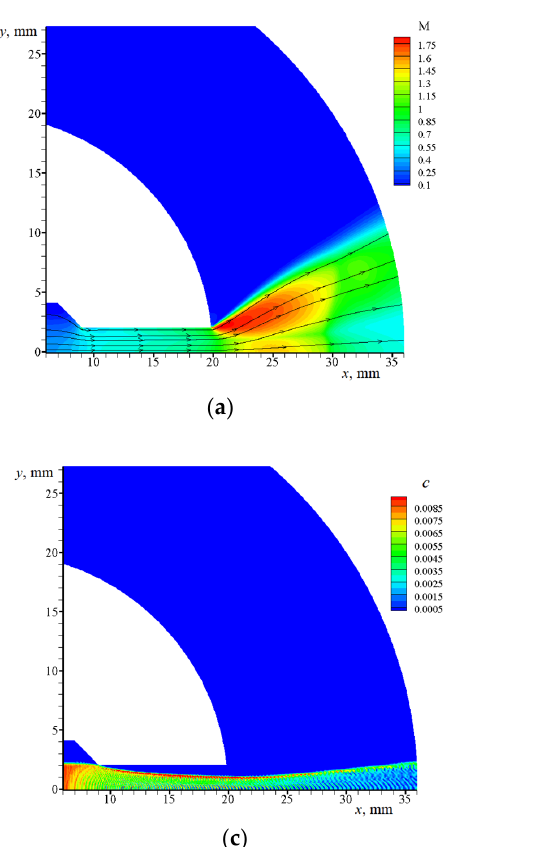
( b ) Figure 7. Results of experiments and calculations performed at 0.2 mm h  : ( a ) distributions of static pressure on the surface of the outer disk on the axis 0 y  in the experiment (symbols) and in the calculations (solid line); ( b ) soot ‐ oil coating on the surface of the outer disk in the presence of two channels of width 17 mm b  and 4 mm b  . The solid line in Figure 7a shows the calculated distribution of pressure along the jet axis. The dashed line shows the curve calculated without taking into account the friction force due to the disks, 0, 0 x y    . Evidently, within the experimental error, a satis ‐ factory agreement between the calculated and experimental results is observed. Figure 7b shows the soot ‐ oil coating shoot after the experiment on the outer disk without pressure holes yet with two channels. The boundaries of the channel and the jets exhausting into the flooded slot space correspond to the black lines in Figure 7b. This case corresponds to a fan ‐ shaped right jet, whose opening angle at the upper boundary of the jet is 25  , and at the lower boundary − 30  . A certain scatter in the angles of the jet opening is apparently due to the non ‐ parallelism of the disks. The calculated jet shown in Figure 5a is also fan ‐ shaped with a half ‐ angle of 30  . Both in calculations and experiments, a supersonic un ‐ derexpanded jet exhausting into a flooded slot space has a fad ‐ like shape. This was due to the action of the friction force on the jet from the side of the discs. In the absence of disks, the supersonic underexpanded jet exhausting into the flooded space has a barrel shape. Note that the numerical calculations described above were performed on a personal computer. One calculation took several minutes. The profound gain in calculation time was due to the fact that in our 2D model there was no need to calculate the boundary layer, in which case, in order to fulfill the condition 1 y   , it was necessary to use a re ‐ fined difference grid. Instead, the 2D Models (3) and (5) use Formula (4) for the drag co ‐ efficient